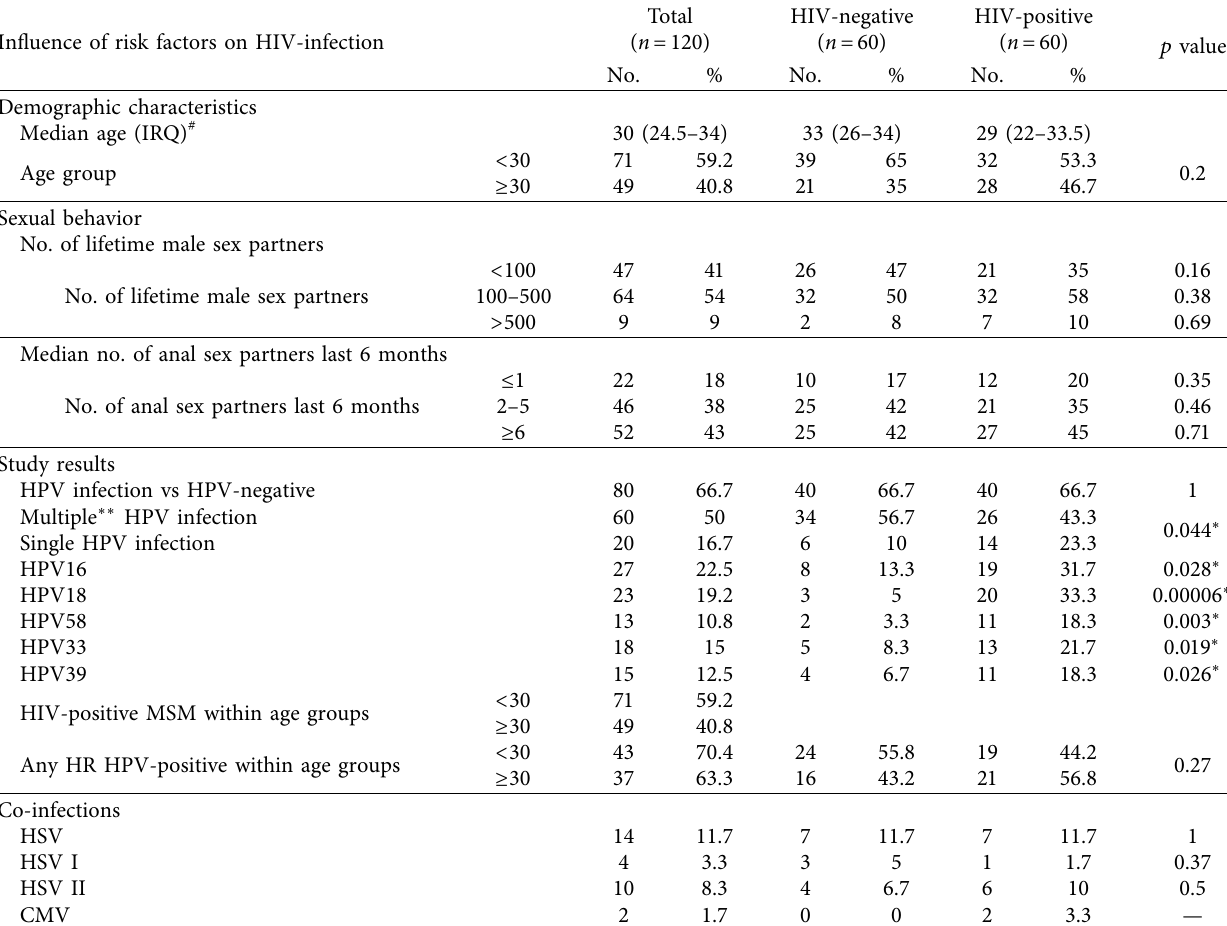
Table 1: Characteristics of the study population ( n � 120) of HIV-positive and HIV-negative MSM from Russia (2016–2017). Influence of risk factors on HIV-infection